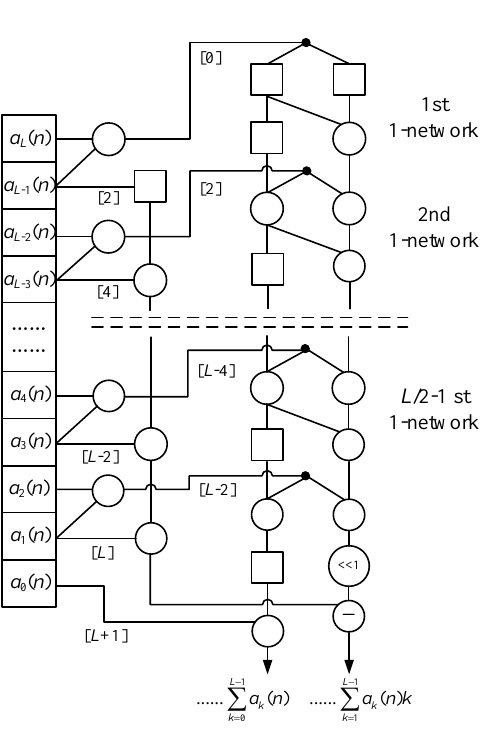
Figure 5. The improved systolic array for first-order moment.